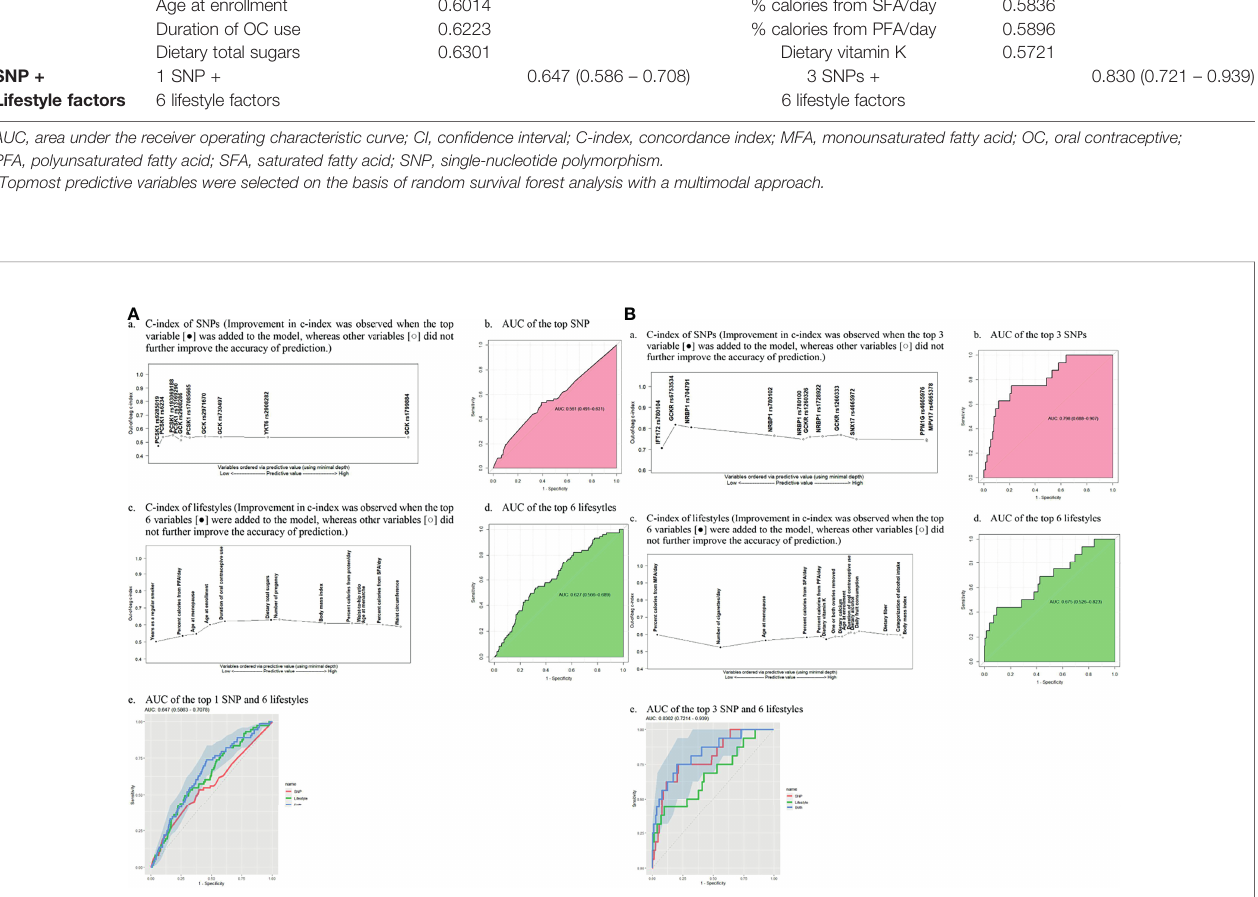
which were determined by their risk distribution in the plot: